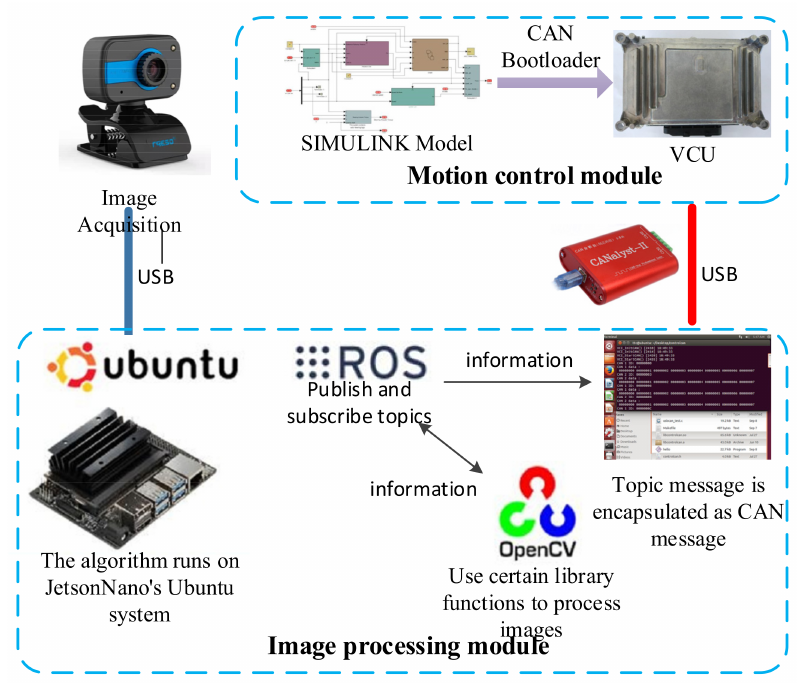
Figure 12. Software system